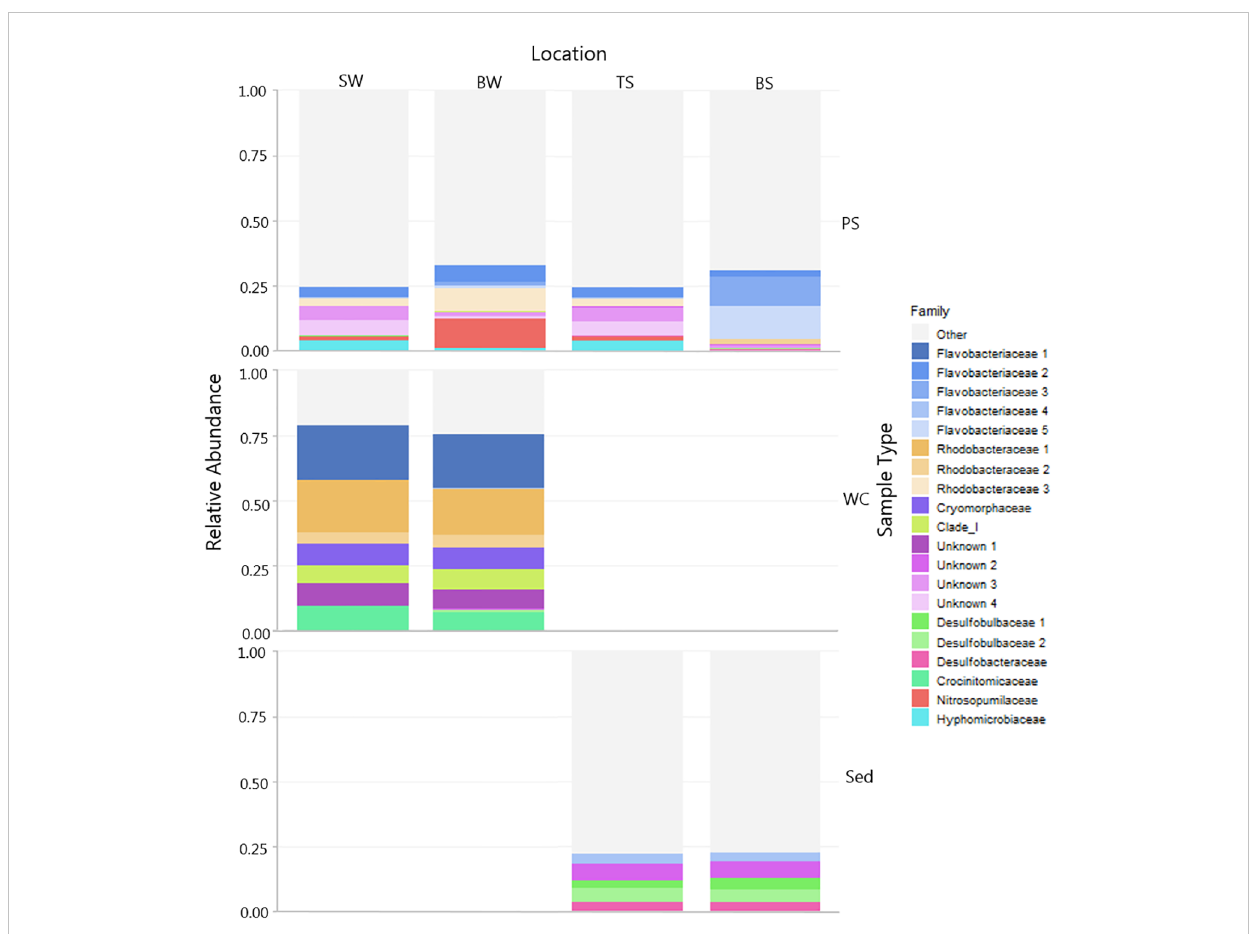
FIGURE 7 Microbial community associated with PS across different compartments (sediment and water) and background samples (water and sediment). The relative abundance of the top 20 ASVs are shown colored by Family. Note samples are divided by sample type and location. Grey shaded areas are other taxa outside the top 20 abundant ASVs. (PS, polystyrene; WC, water column; Sed, sediment; SW, surface water; BW, bottom water; TS, top sediment'; BS, bottom